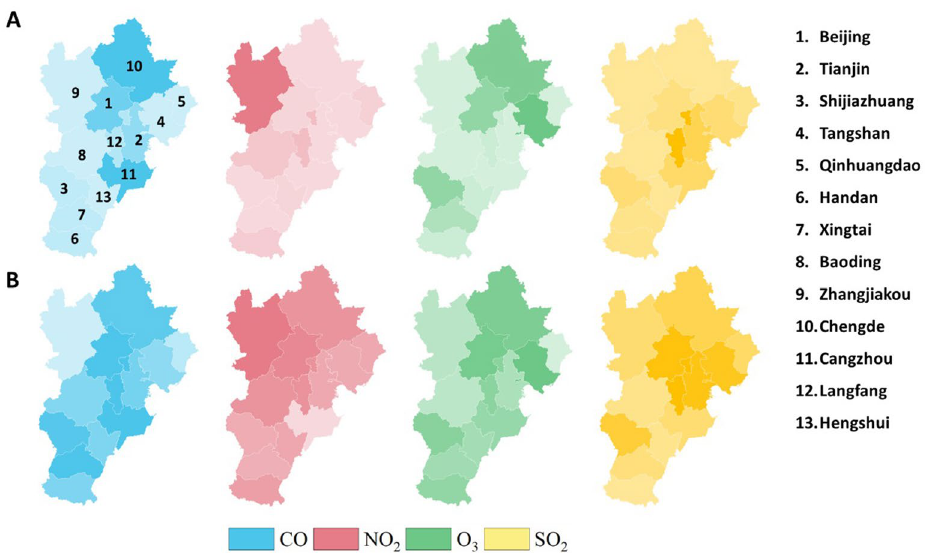
Figure 2. Maps of the ( A ) betweenness centrality and ( B ) clustering coefficients. The maps were drawn with R package ggplot2 version 3.3.3, https:// ggplo t2. tidyv erse.